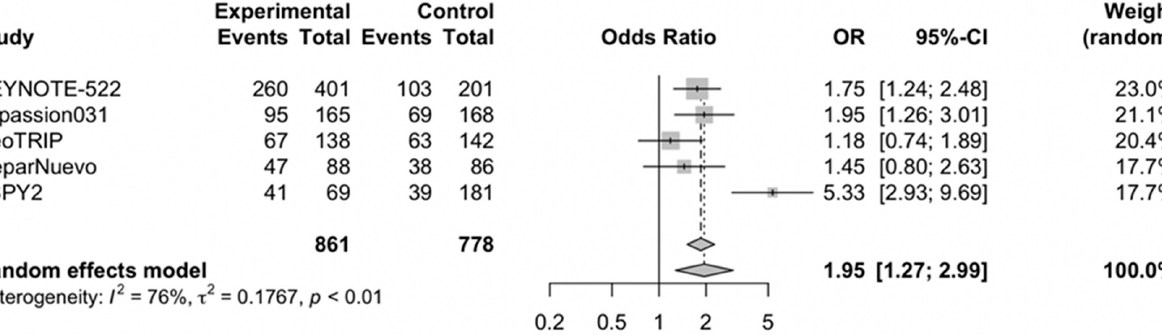
Figure 3. Forest plot of comparison between neoadjuvant chemoimmunotherapy versus chemotherapy alone in early-stage triple-negative breast cancer patients; the outcome of interest was pathological complete response (pCR) rate. Abbreviations: OR: odds ratio.